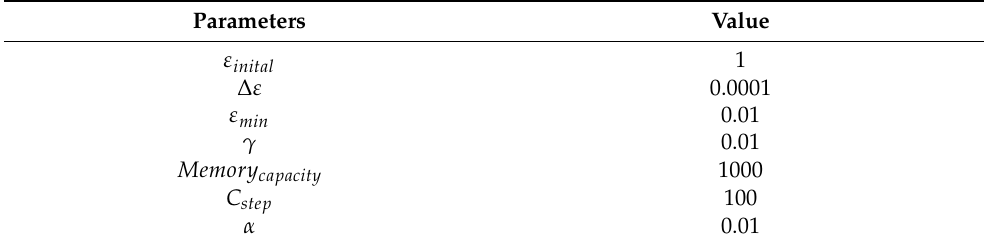
Table 1. Parameters of DF-DQN and